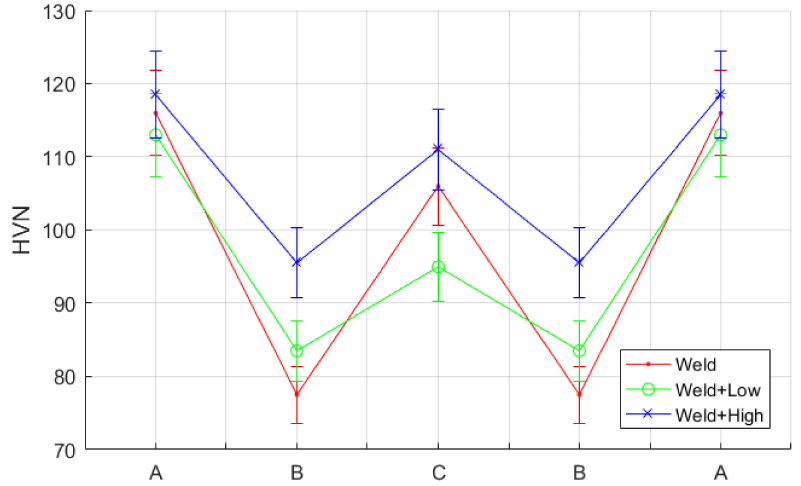
Figure 16. Hardness profile measurements for welded and shot-peened samples for the three regions of interest in Figure